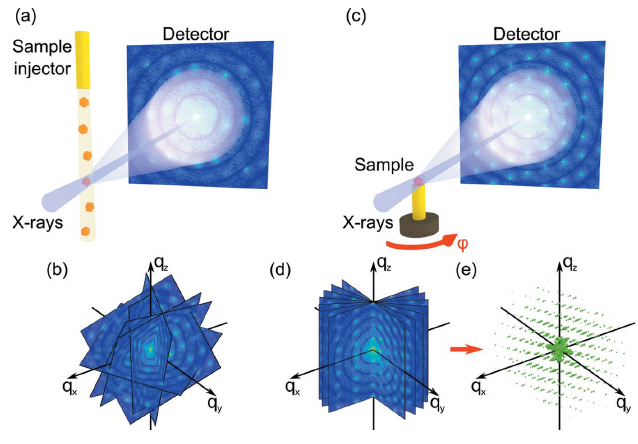
Figure 1 ( a ) Scheme of the experimental setup for measuring 2D diffraction patterns from different randomly oriented samples injected into the incident X-ray beam. The patterns collected represent random cuts of 3D reciprocal space as shown in ( b ). ( c ) Scheme of the experimental setup for measuring 2D diffraction patterns from a single sample rotated around an axis normal to the incident beam. ( d ) 2D patterns of known orientation can be further interpolated into 3D intensity distribution ( e